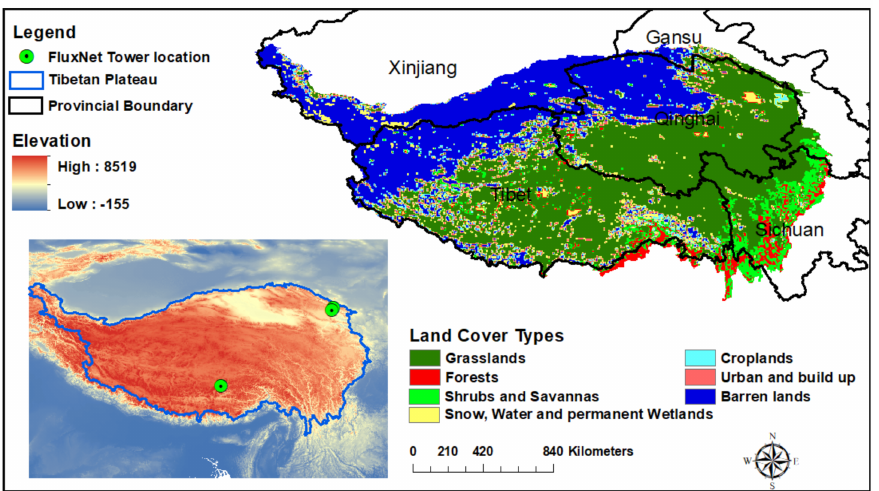
Figure 1. Administrative and land cover map of the Tibetan Plateau (TP). The boundary of TP is obtained from Yili [43] (DOI:10.3974/geodb.2014.01.12.V1). The land cover map is prepared from MODIS mcd12c1 data; 17 IGBP land cover classes are reclassified and merged into 7 major land covers in TP; insight shows the elevation map of TP using SRTM30 data set (download from https://earthexplorer.usgs.gov/) and locations of FluxNet tower